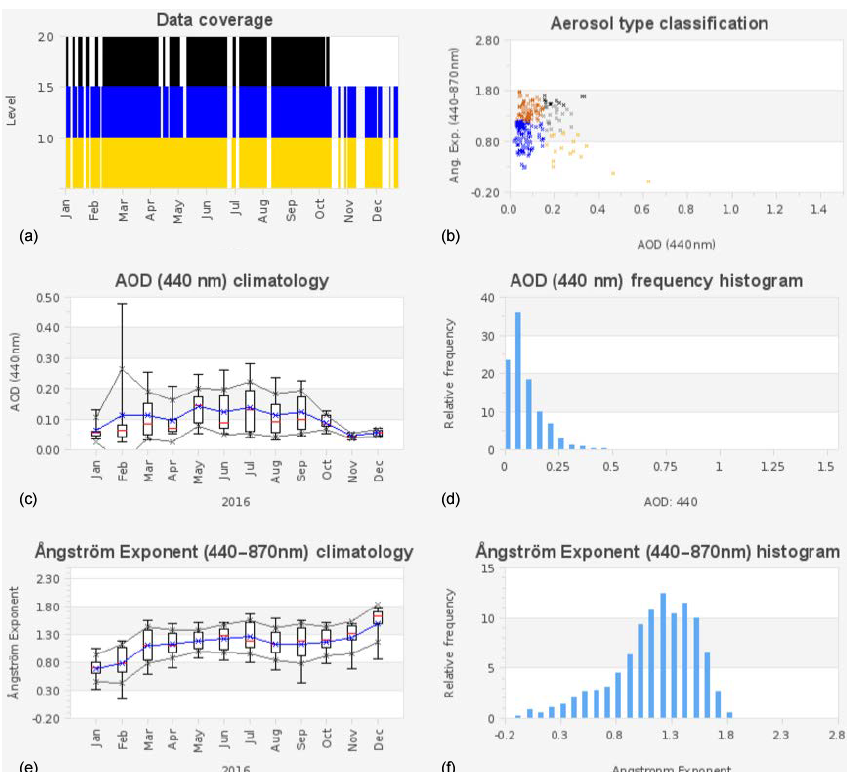
Figure 11. Statistical analysis of aerosol optical depth (AOD) and Ångström exponent (AE) derived from AERONET for Palencia site in 2016: (a) data coverage for level 1.0, 1.5 and 2.0 of the AERONET database; (b) aerosol type classification based on the AOD vs. AE scatter plot. (c) AOD (440nm) monthly statistics using box plot; (d) frequency histogram for AOD (440nm); (e) AE monthly statistics using box plot; (f) frequency histogram for